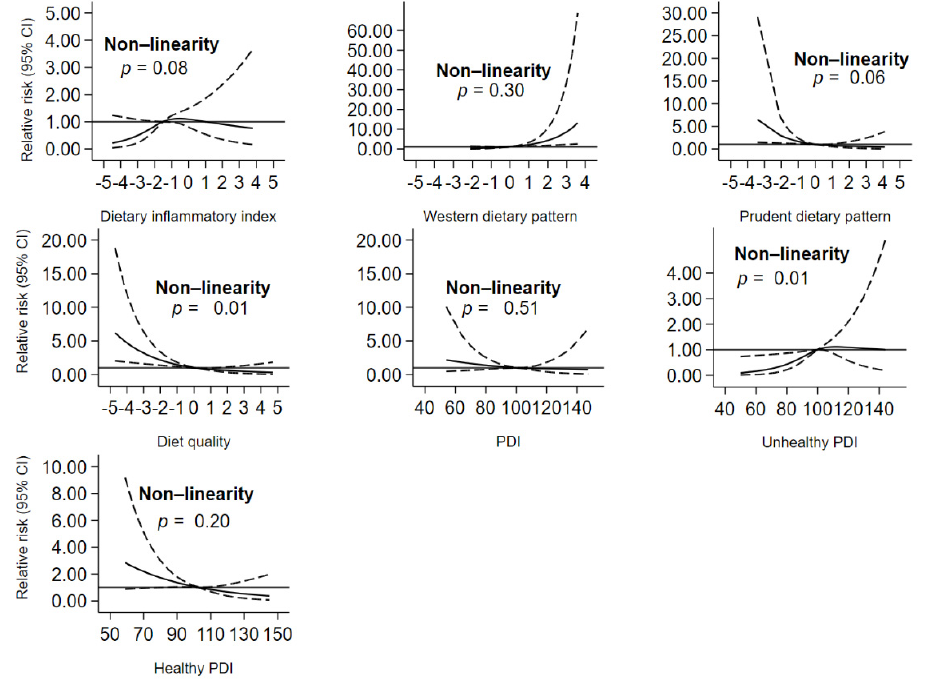
Figure 2. Dose–response relationship curve showing the relationship between dietary constructs and the risk of obesity. PDI: Plant-Based Dietary Index. the risk of obesity. PDI: Plant-Based Dietary